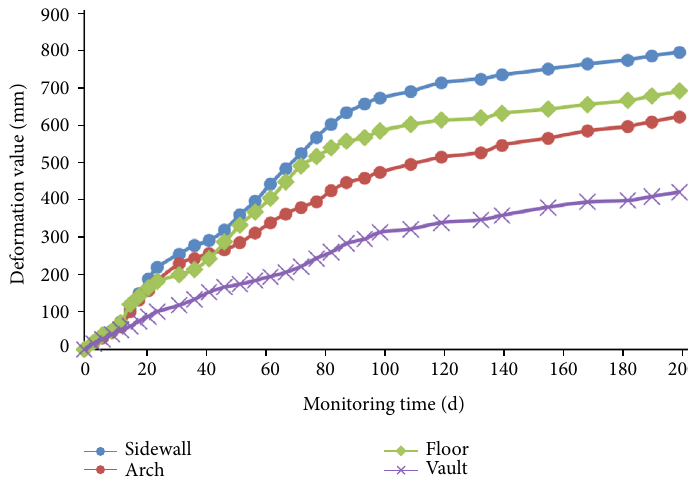
Figure 4: Deformation monitoring curve of the